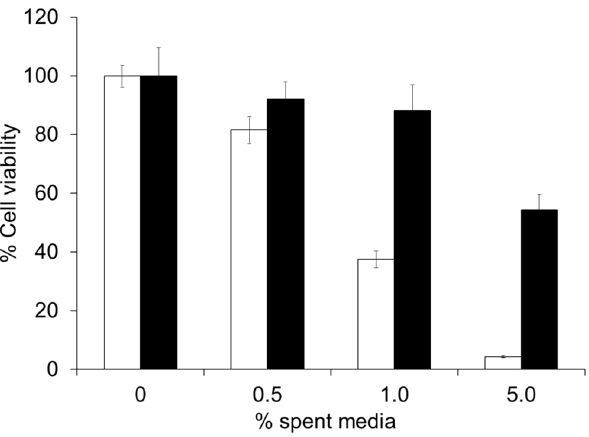
Figure 4. Inhibition of C.difficile toxin production by CamSA treatment. C. difficile spores were incubated overnight in media containing 0 m M CamSA (white bars) or 200 m M CamSA (black bars). The resulting spent media were added to Vero cell cultures and incubated for 24 hours. Cell viability was determined with the CellTiter Glo viability kit. The luminescence signal from untreated cells was set as 100% cell viability. Percent survival for other conditions was calculated relative to untreated cells. Error bars represent standard deviations from at least five independent measurements.